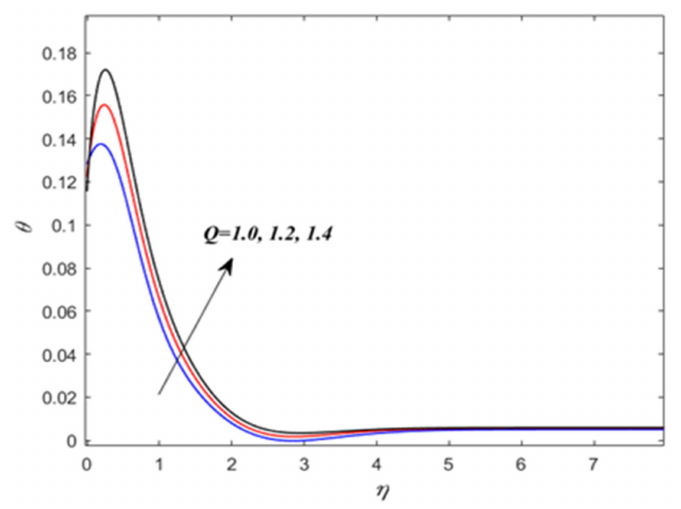
Figure 6. Various values of radiation parameter ( R ) on temperature θ ( η ) .